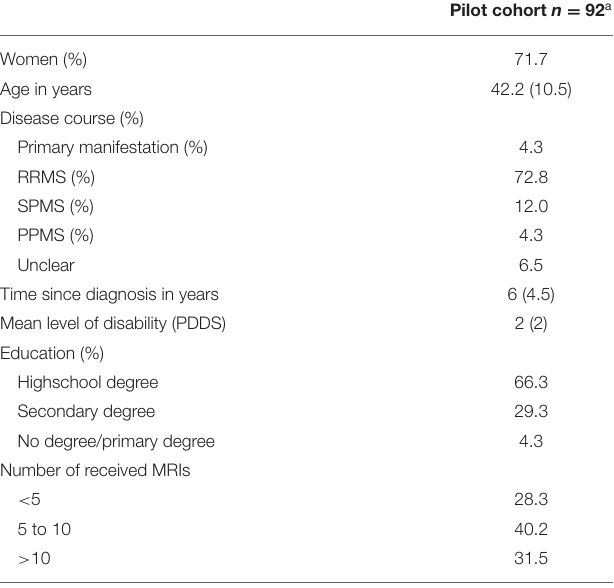
TABLE 2 | Demography of the pilot cohort.